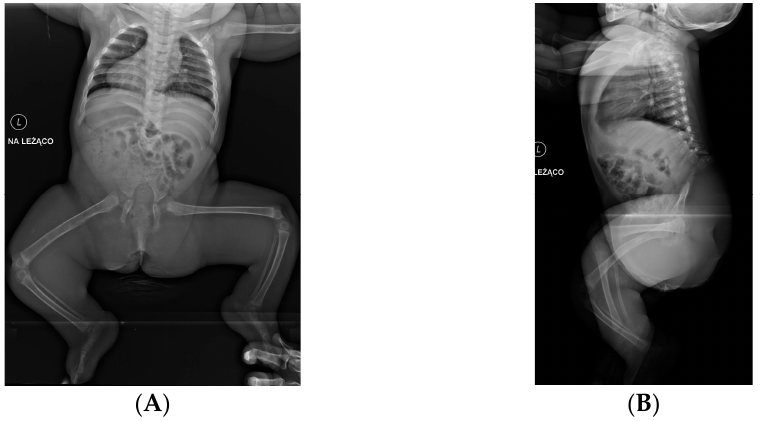
Figure 3. 8-month-old girl with complete absence of sacrum. ( A )—ap view, ( B )—lateral view.